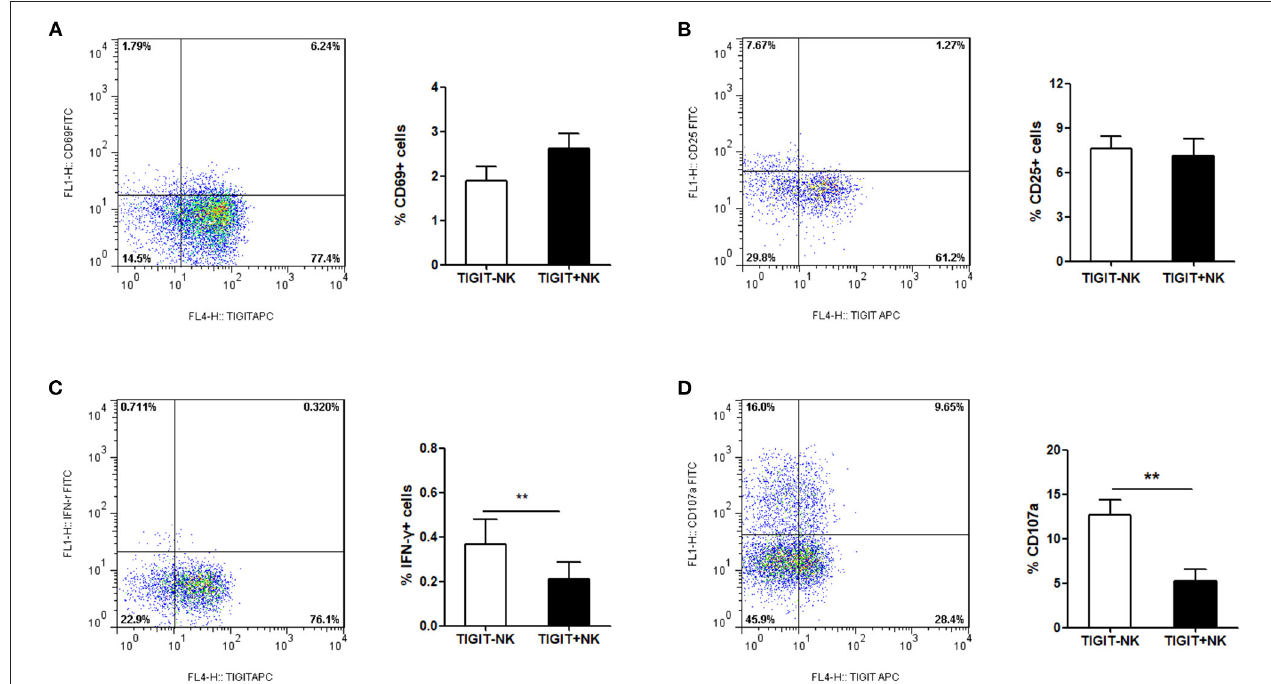
FIGURE 2 | TIGIT expression and NK-cell phenotype in CHB. PBMCs isolated from healthy individuals were analyzed by flow cytometry without any stimulate. FACS plot showing the expressions of CD69 (A) or CD25 (B) on NK cells from a representative CHB-IA patient. CD69 expression on TIGIT- or TIGIT + NK cells is shown as the mean ± SEM (n = 12 subjects per group). (C) FACS plot showing the expressions of IFN- γ in NK cells from a representative CHB-IA patient. Expression on TIGIT- or TIGIT + NK cells is shown as the mean ± SEM (n = 8 subjects per group). (D) FACS plot showing the expressions of CD107a on NK cells from a representative CHB-IA patient. CD107a expression on TIGIT- or TIGIT + NK cells is shown as the mean ± SEM (n = 9 subjects per group). Data are from a single experiment representative of three. * p < 0.05, ** p < 0.01, *** p < 0.001.